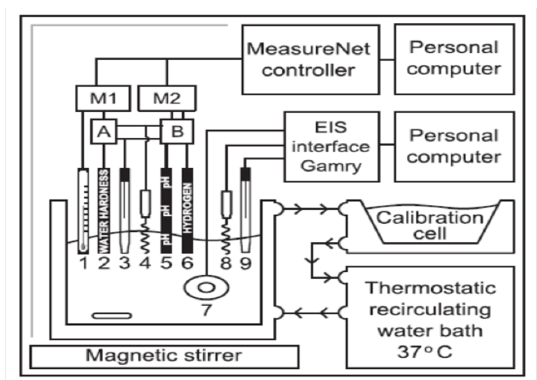
Figure 6. CCS system instrument and cell layout. ( 1 ) Temperature instrument, ( 2 ) Sensor for water hardness, ( 3 ) Reference electrode, ( 4 ) Pt solution ground, ( 5 ) pH sensor, ( 6 ) H 2 sensor, ( 7 ) Working electrode, ( 8 ) Pt auxiliary electrode, ( 9 ) Reference electrode, A, B, pre amplifiers; M1, M2, MeasureNet workstations